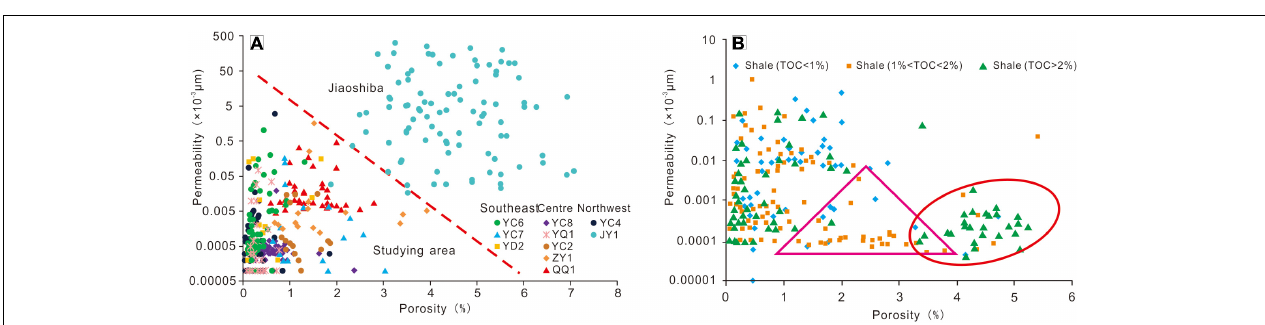
FIGURE 7 | (A) Pore-permeability intersection diagram of shale from the Wufeng-Longmaxi Formation in southeastern Chongqing,compared with those in Jiaoshiba area (data from JY 1 well were obtained from Guo et al., 2014b). (B) Pore-permeability intersection diagram of shale with different percent of TOC content from the Wufeng-Longmaxi Formation in southeastern Chongqing. YC6 denotes the serial number of well drilling.